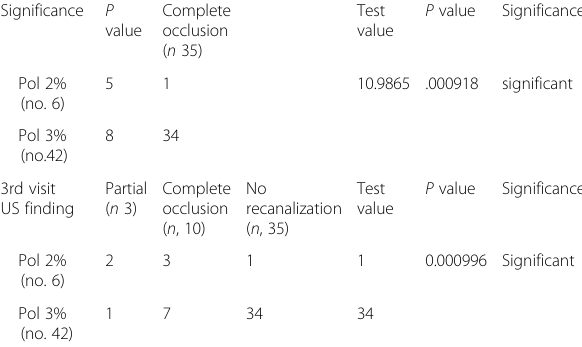
Table 11 Relation between polidocanol injected and the US follow-up findings in both 2nd and 3rd sessions Significance P Complete value occlusion